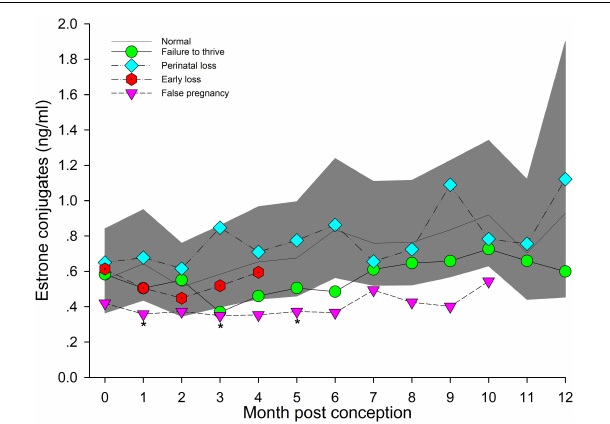
FIGURE 5 | The marginal predicted 95% CI for estrone conjugates during each month post-conception (MPC) of normal pregnancies as represented by the dark gray shaded portion of the graph and the mean by a solid black line. Line graphs with data points represent each abnormal pregnancy (marginal mean). MPC of abnormal pregnancies which have mean concentrations that are significantly different from normal are highlighted with an asterisk (*). Data were log transformed for analysis and then back-transformed for data